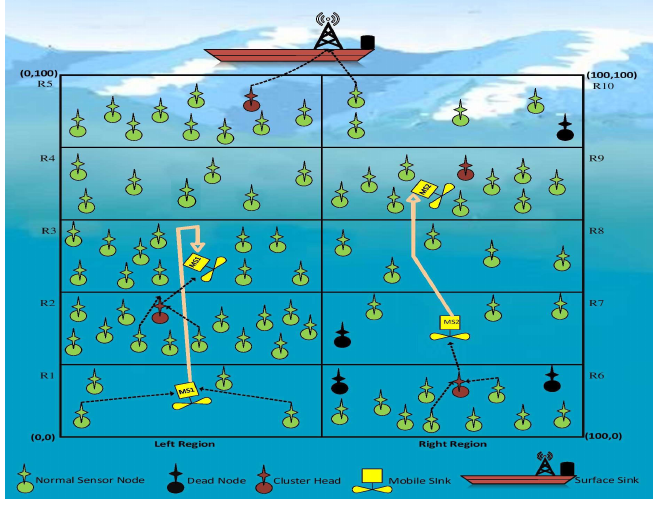
Figure 1. Network